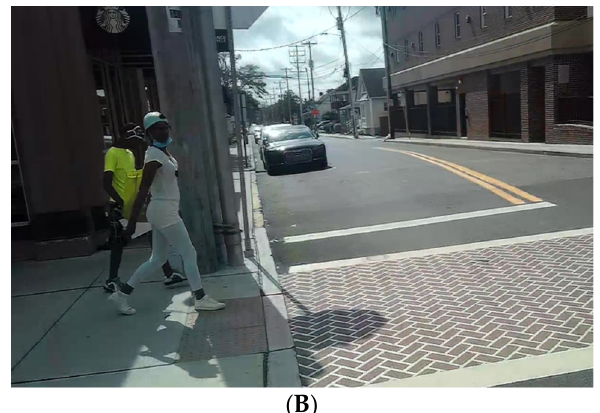
Figure 4. Street view with facial capture ( A ): people orientated in same direction as observer; ( B ): side video of people seen in (A).